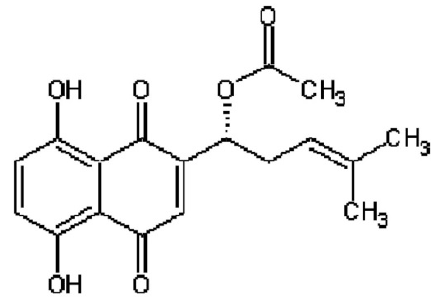
Figure 1. Chemical structures of acetylshikonin.